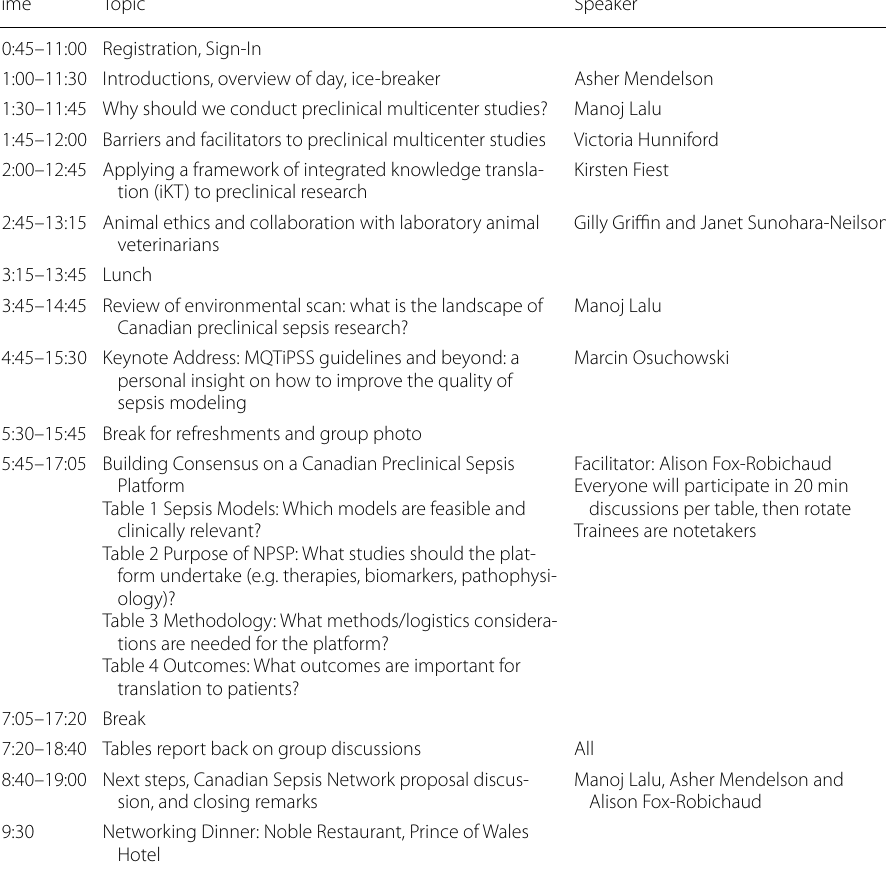
Table 1 Sepsis Models: Which models are feasible and clinically relevant? Table 2 Purpose of NPSP: What studies should the plat‑ form undertake (e.g. therapies, biomarkers, pathophysi‑ ology)? Table 3 Methodology: What methods/logistics considera‑ tions are needed for the platform? Table 4 Outcomes: What outcomes are important for translation to